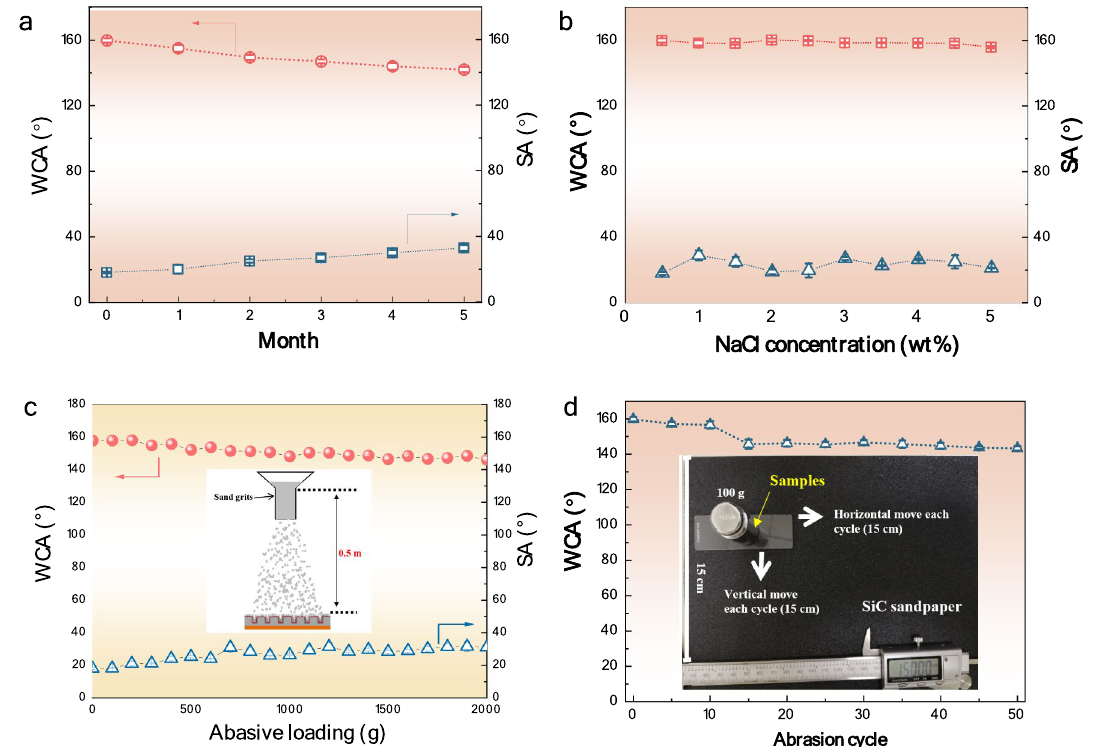
Figure 4. Chemical stability and mechanical robustness of the coating PCF. ( a ) Water contact angle (WCA) and sliding angles (SA) measured on the coating after different months. ( b ) WCAs and SAs measured with NaCl solution droplet with different concentrations. ( c ) WCAs and SAs measured after the coating PCF suffered from different amounts of Al 2 O 3 sand abrasive loading (inset schematically illustrates the sand abrasion test). ( d ) WCAs variations of the coating PCF with sandpaper abrasion cycles (inset shows the technical model of the sandpaper abrasion